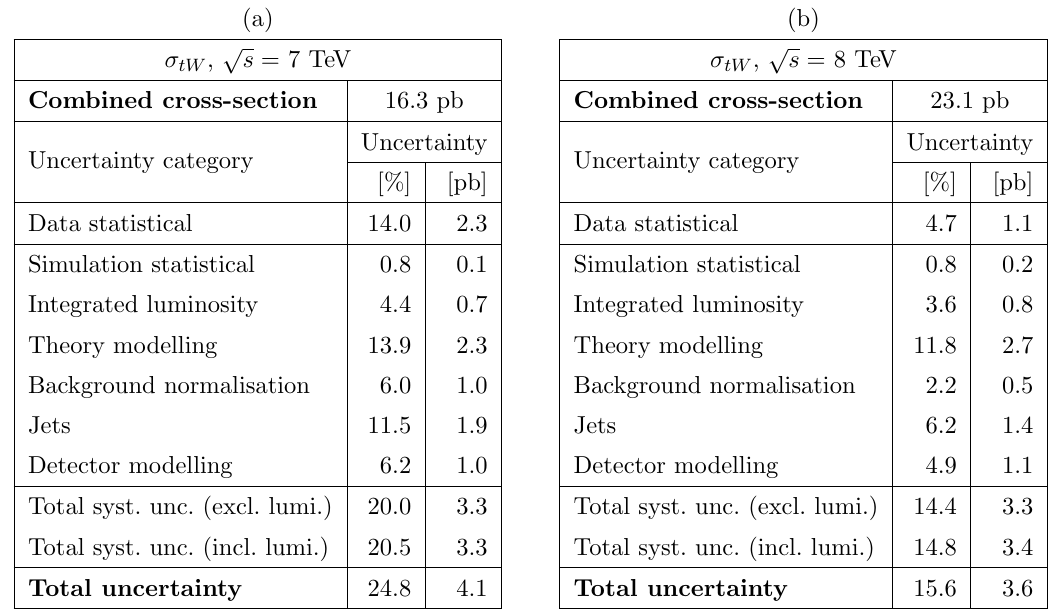
Table 4 . Contribution from each uncertainty category to the combined tW cross-section ( (cid:27) tW ) uncertainty at (a) p s = 7 TeV and (b) p s = 8 TeV. The total uncertainty is computed by adding in quadrature all the individual systematic uncertainties (including the uncertainty in the integrated luminosity) and the statistical uncertainty in data. Correlations of systematic uncertainties between experiments are presented in appendix